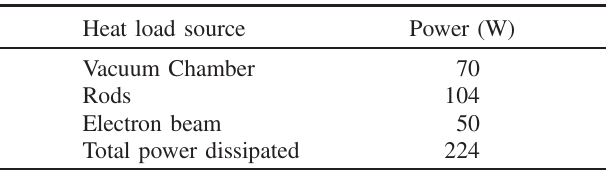
TABLE III. Total heat load dissipated by the liquid nitrogen close